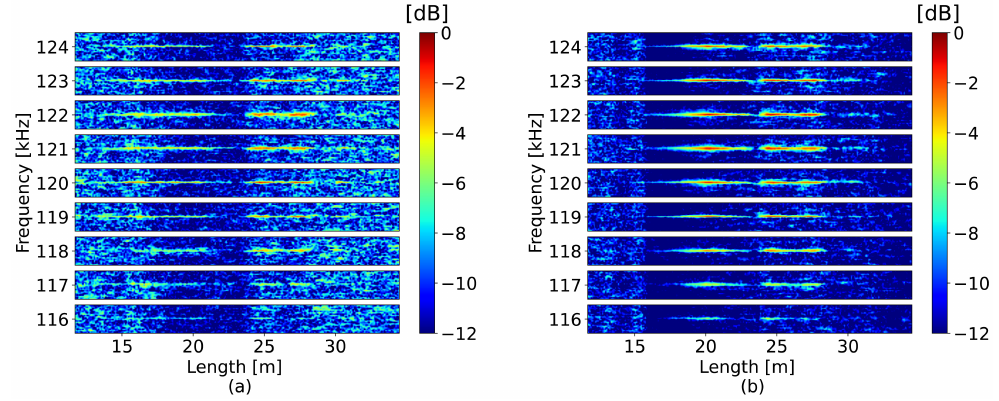
Figure 6. Perturbations of increased complexity detected by ( a ) the standard method and ( b ) the neural network (demonstrated spectral width around each component was 100